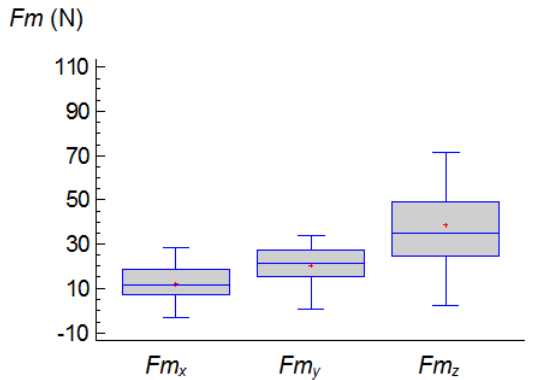
Fm and Fm x , y z